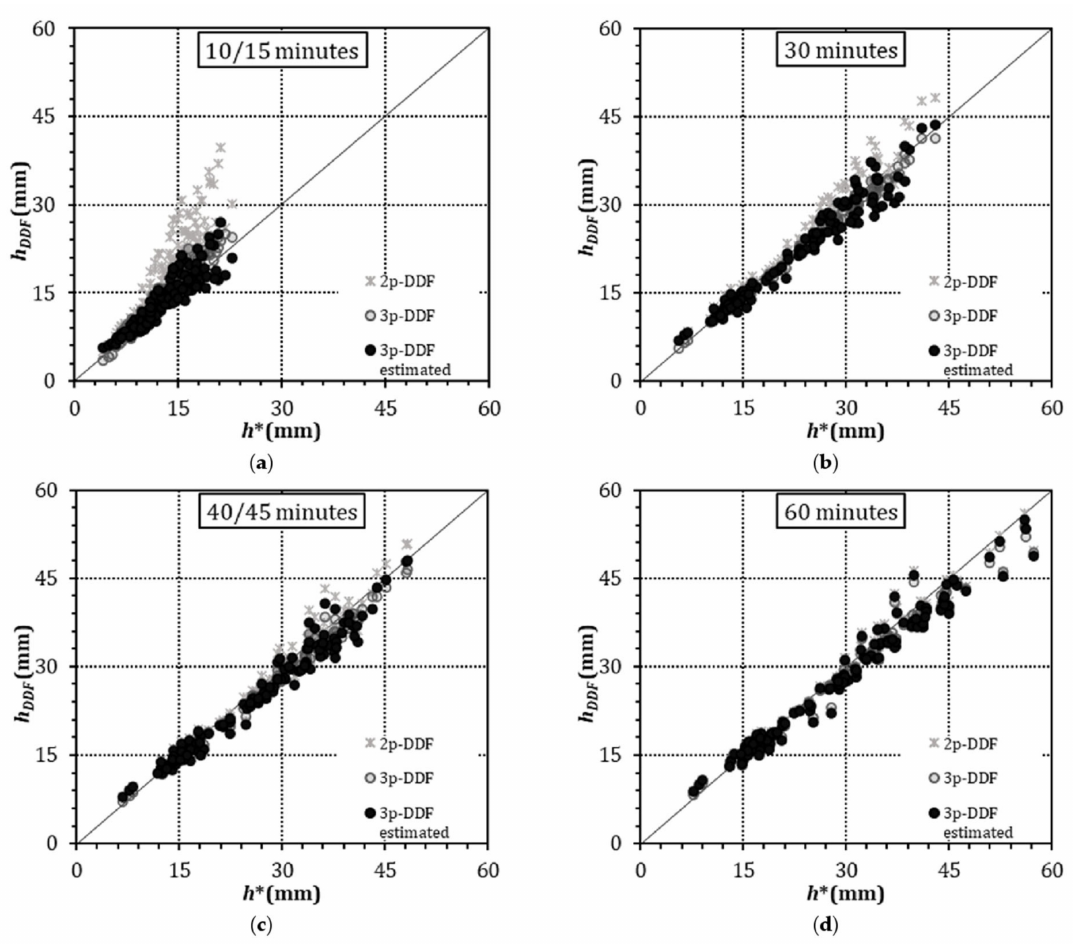
Figure 5. Comparison of rainfall depths from Gumbel distributions ( h * ) and from 2p-DDF, 3p-DDF, and 3p-DDF estimated curves ( h DDF ), for return period of 5, 10, and 15 years and duration of ( a ) 10/15 min, ( b ) 30 min, ( c ) 40/45 min, and ( d ) 60